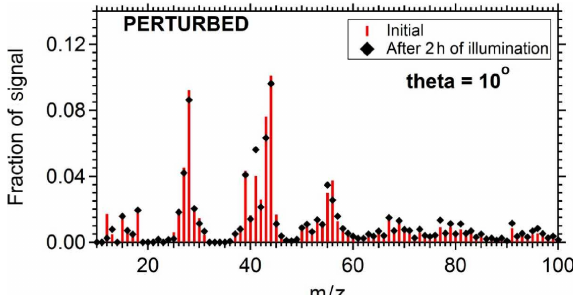
Figure 9. The organic mass spectra after filling and after 2h of UV illumination in the perturbed